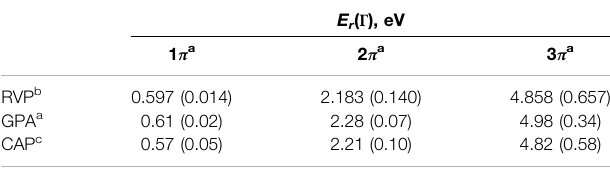
TABLE 3 | Energy positions ( E r ) and widths ( Γ , in parenthesis) of the lowest three shape-type resonances of uracil anion calculated using RVP and compared with other theoretical works. Adopted from Ref.